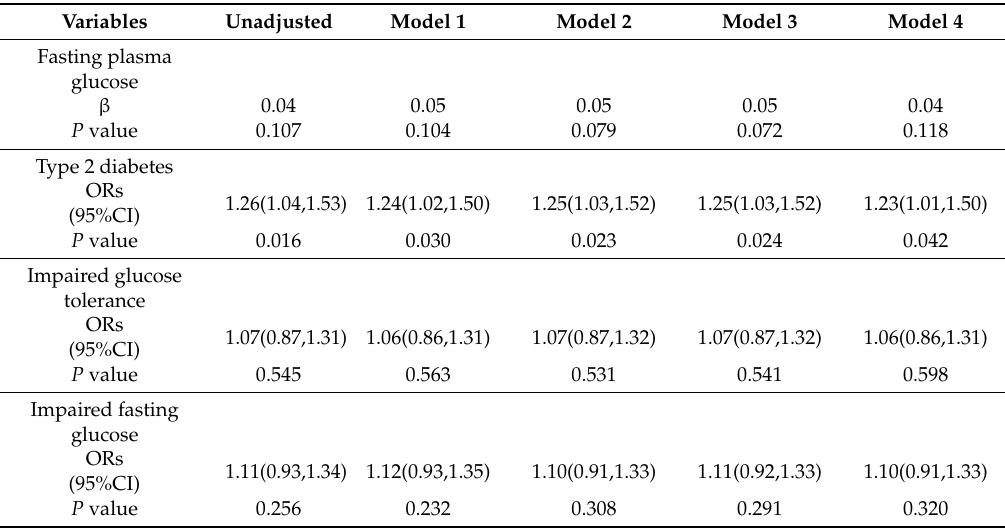
Table 2. The associations between fetal famine exposure and the risk of dysglycemia in